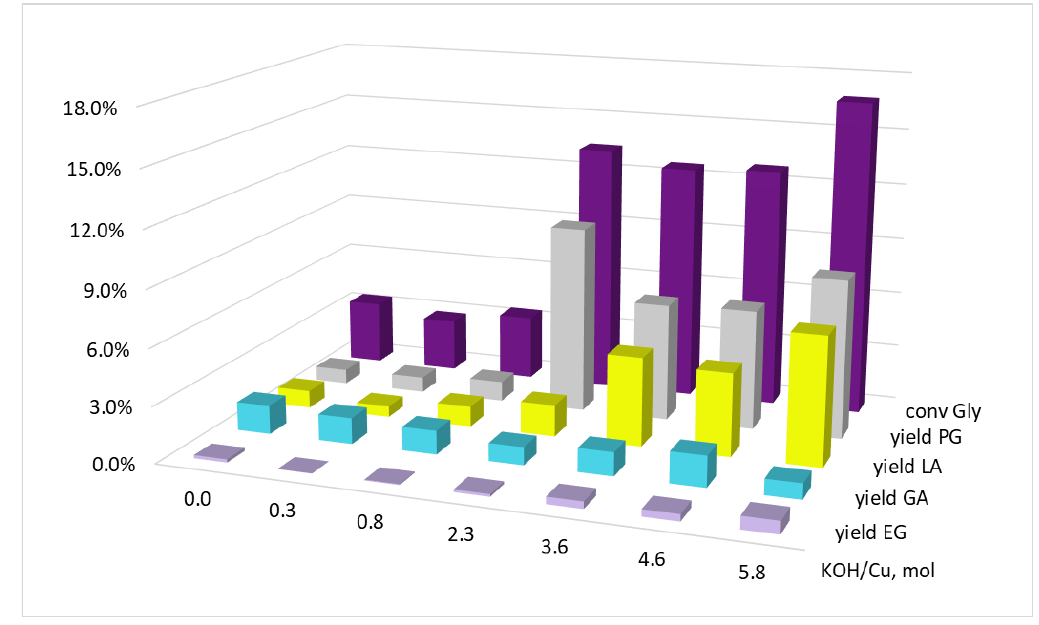
Figure 2. The influence of the KOH/Cu molar ratio on the glycerol conversion and the yields of the products. Conditions: T = 220 °C, p(H 2 ) = 3.0 MPa, Gly/Cu = 50 mol, τ = 5 h, precursor salt = Cu(OAc) 2 .